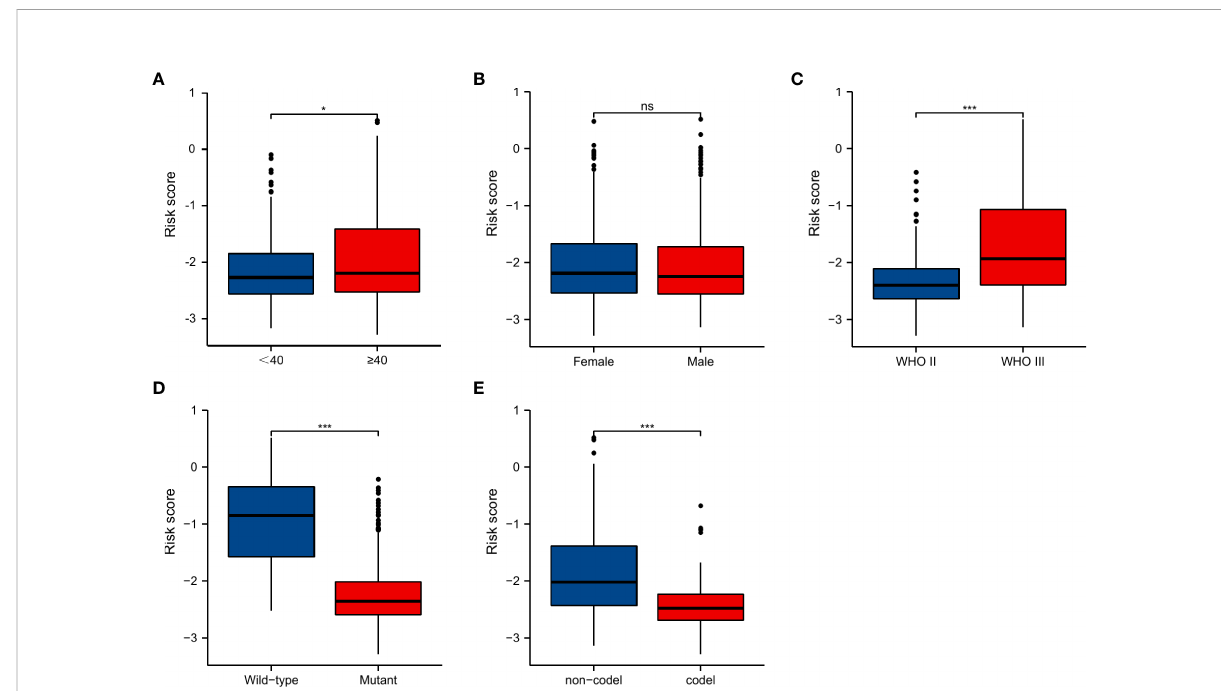
FIGURE 5 SnG-risk score distributions in LGGs strati fi ed by different clinicopathologic features, including age, gender, WHO grade, IDH status, and 1p/19q co-deletion status. *P<0.05; ***P<0.001. (A) Age, (B) Gender, (C) WHO grade, (D) IDH status, (E) 1p/19q co-deletion status. ns, not signi fi